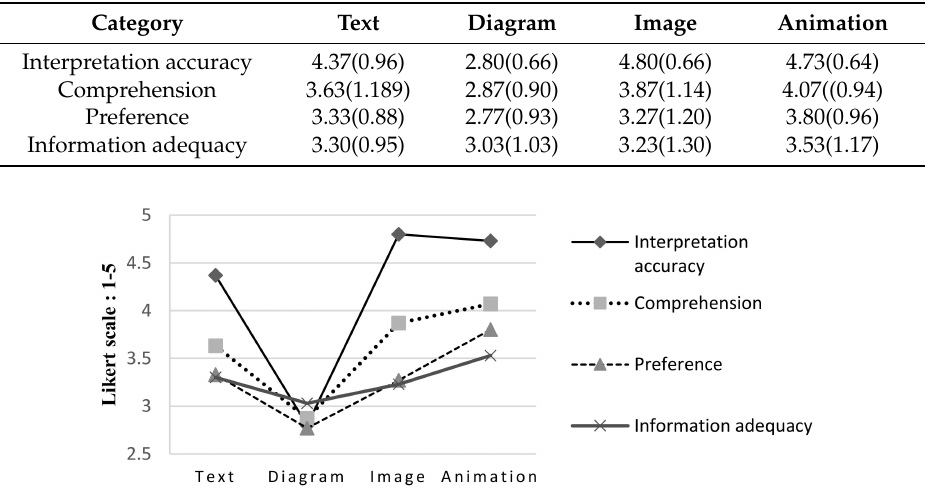
Figure 7. Comparison of interpretation accuracy, comprehension, preference, and information adequacy (unit: points; five-point Likert